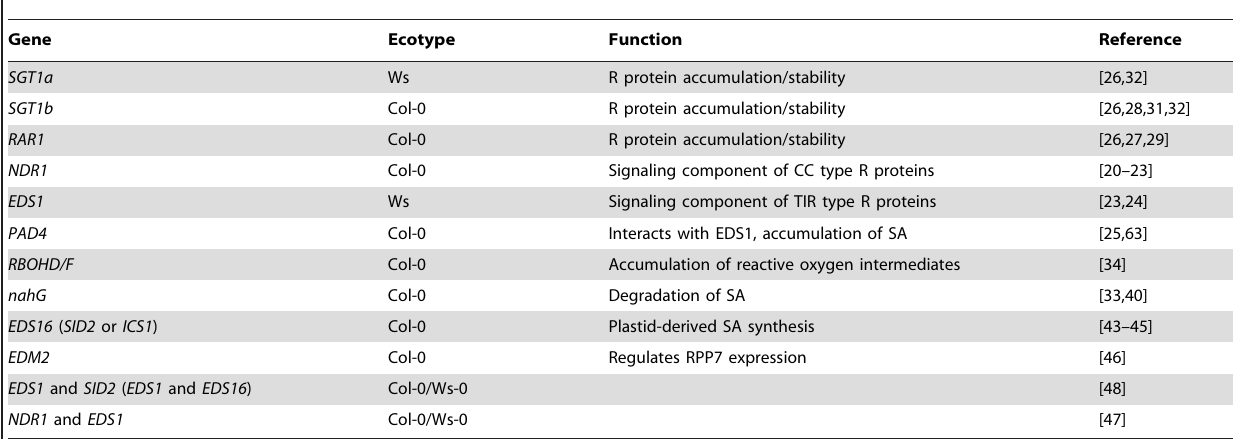
Table 1. Arabidopsis Resistance signaling genes addressed in this study.